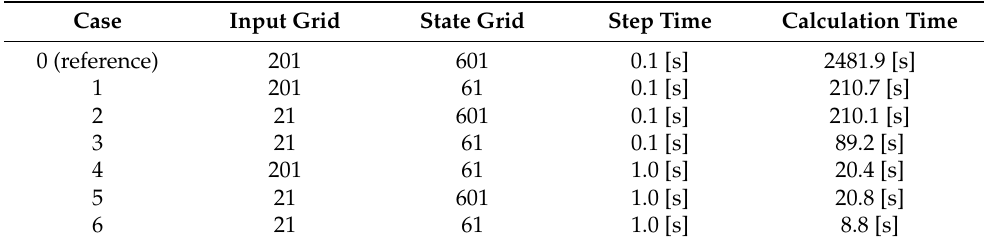
Table 2. Settings for comparison groups